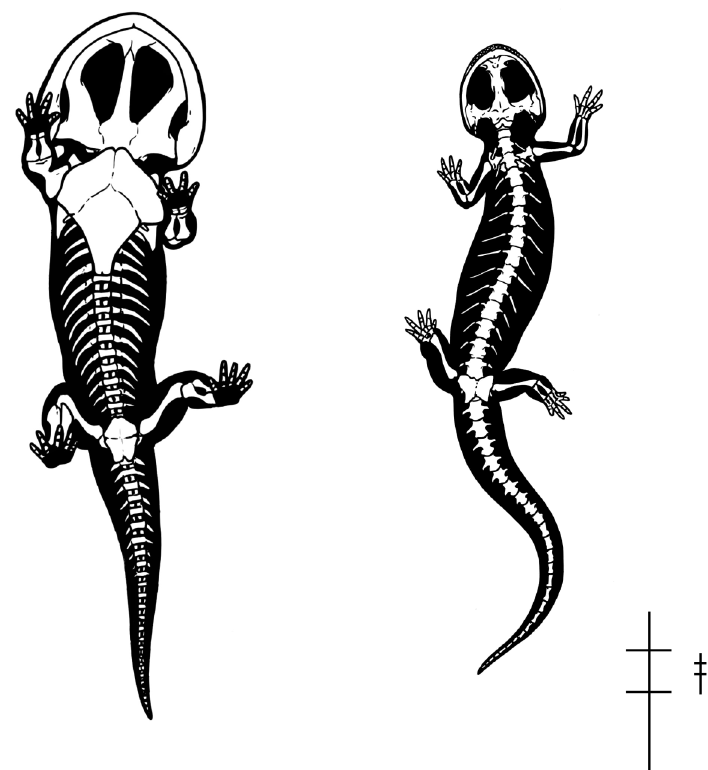
Figure 10. Comparison of the body shape in a Siderops -like temnospondyl (left), which is inferred to be the Episcopopus trackmaker, and a salamander (right). Skeletal silhouettes are shown in ventral view. We calculated the glenoacetabular distance for the temnospondyl to be ca. 130 cm, and its body form is based on comparisons with complete skeletons of Mesozoic stereospondyls, such as the Australian chigutisaurid Siderops [22] and the European capitosauroid Mastodonsaurus [23]. The salamander body is based on Dicamptodon ensatus (UMMZ 135631) and skeletal information from http://digimorph.org/specimens/Ambystoma_tigrinum/whole/. Important differences between these two include relative size and ossification of the skull and pectoral girdle, robustness of dorsal ribs, and degree of ossification of carpal, tarsal, and metapodial elements. Silhouette reconstructions are not to scale; see schematics at the bottom right size proportions.